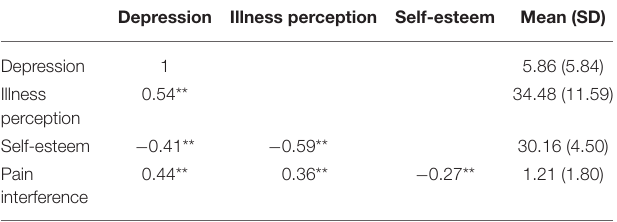
TABLE 2 | Sample correlations and mean (SD) of the main variables ( n =